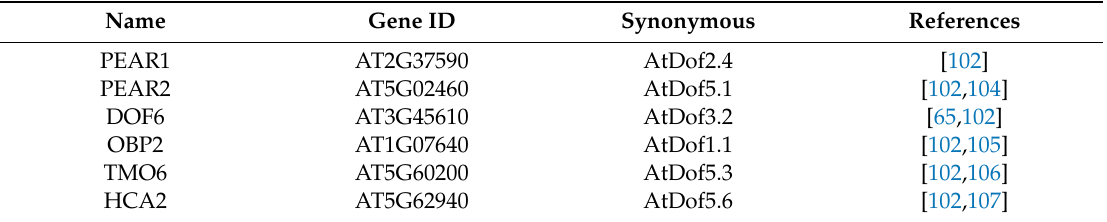
Table 2. Arabidopsis DOF genes encoding PHLOEM EARLY DOF (PEAR)